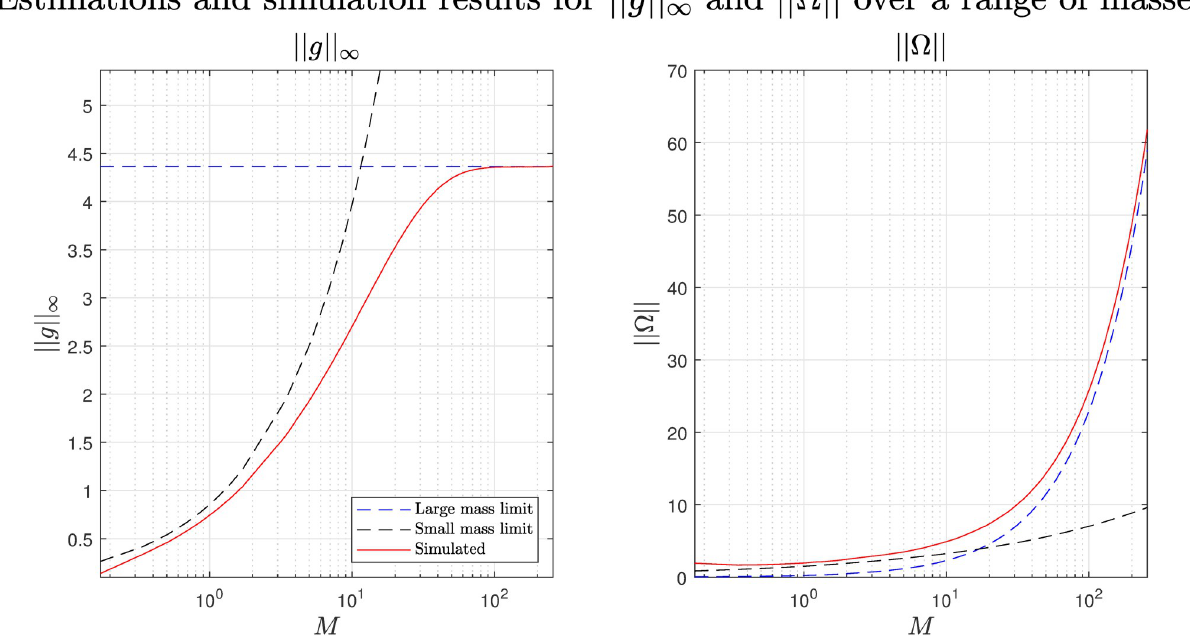
PLOS Computational Biology | https://doi.org/10.1371/journal.pcbi.1008353 July 7,